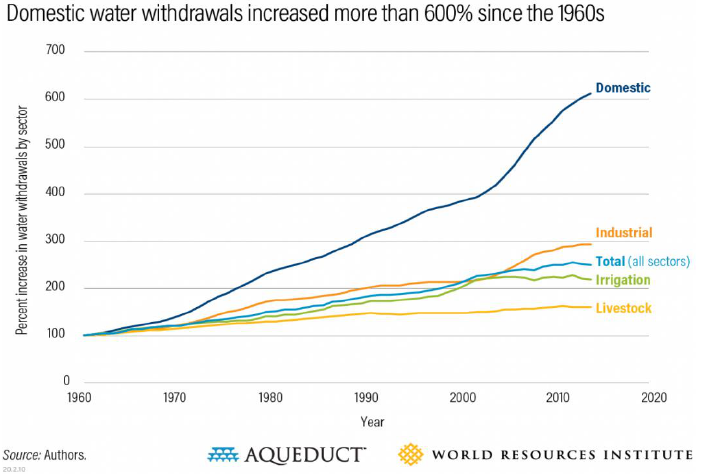
Figure A1. Global water use increase, 1960–2014. Source: https://www.wri.org/insights/domestic-water-use-grew-600-over-past-50 years (accessed on 17 June 2021).